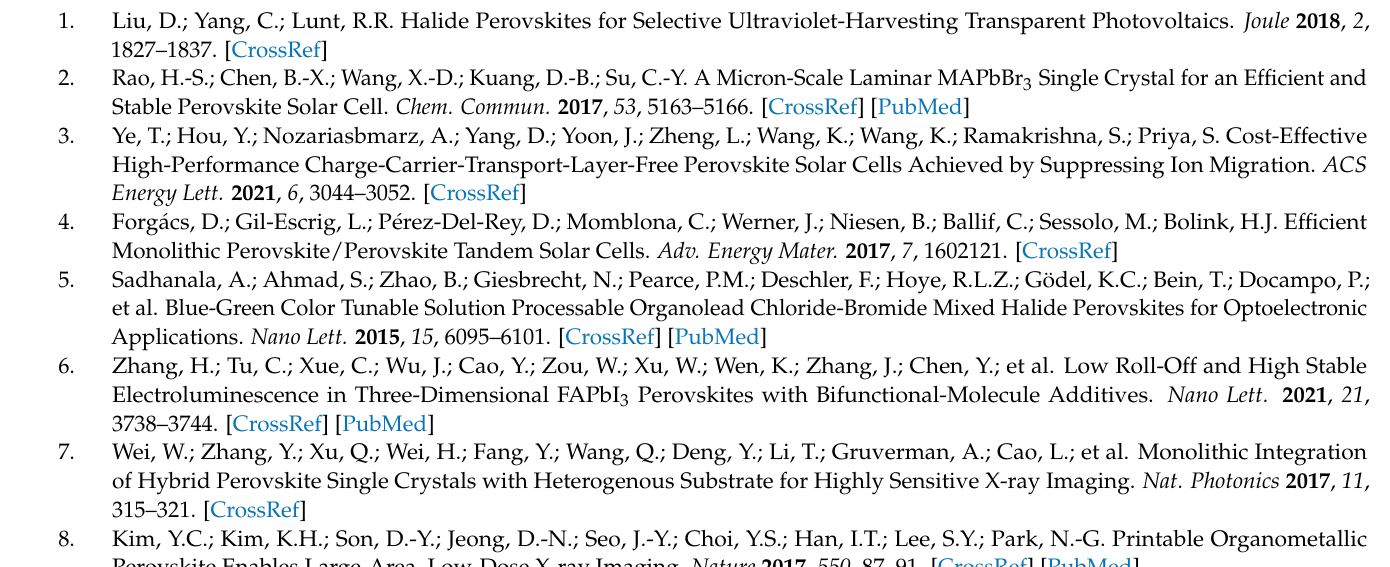
and PL peak energy; TRPL; TRMC; Fitting parameters (PDF). Figure S1: (a) Absorption spectra of MAPb(Br 1 − y I y ) 3 single crystals measured by integration sphere method. (b) Bandgap energy obtained by Tauc analysis. (c) The correlation between PL peak energies and I compositions for MAPb(Br 1 − y I y ) 3 single crystals, Figure S2:TRPL kinetics of MAPb(Br 1 − y I y ) 3 single crystals with (a) y = 0; (b) y = 0.73; (c) y = 0.82; (d) y = 1 under different excitation fluencies, Figure S3: Comparison between TRMC and TRPL kinetics of MAPb(Br 1 − y I y ) 3 single crystals with (a) y = 0; (b) y = 0.73; (c) y = 0.82; (d) y = 1 at room temperature. The solid lines are fitting curves based on multiple exponential decay functions, and the detailed fitting parameters are shown in Table 2. Figure S4: TRMC kinetics of MAPb(Br 1 − y I y ) 3 single crystals with (a) y = 0; (b) y = 0.73; (c) y = 0.82; (d) y = 1 under different excitation fluencies, Table S1. Lattice parameters of MAPb(Br 1 − y I y ) 3 single crystals with different I